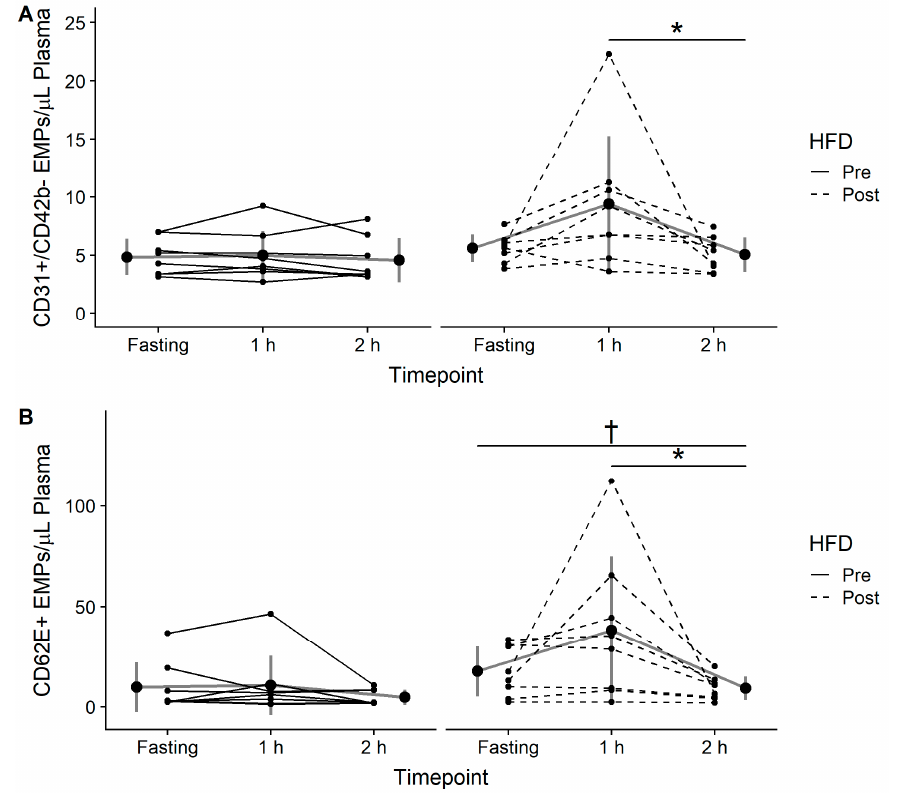
Figure 2. ( A ) CD31+/CD42b- endothelial microparticles (EMPs) and ( B ) CD62E+ EMPs assessed in the fasting state (Fasting), 1-hour (1 h), and 2-hours (2 h) following consumption of a 75-g glucose drink pre and post 7-day high-fat diet (HFD). Data are expressed as the mean ± standard deviation (gray lines and large circles) and individually (solid and dashed black lines and small circles). Significant difference from 1 h to 2 h post-HFD is denoted as * ( p < 0.05), significant difference from fasting to 2 h post-HFD is denoted as † ( p < 0.05).